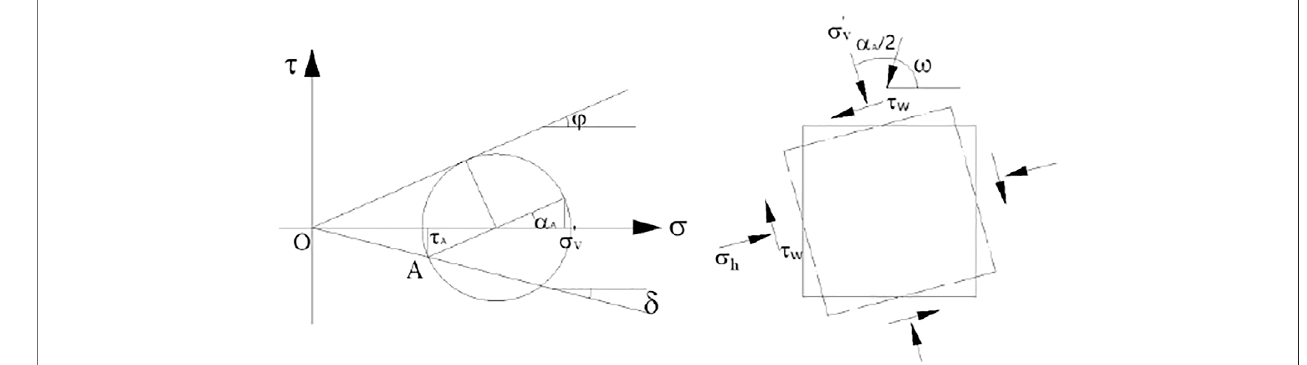
FIGURE 5 | Mohr ’ s circle of stress at point A.